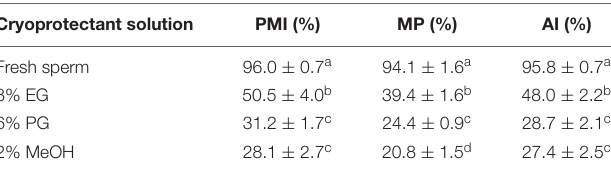
TABLE 3 | Comparison of plasma membrane integrity (PMI), mitochondrial potential (MP), and acrosome integrity (AI) between fresh and cryopreserved sperm (mean ± SD) ( n = 6).